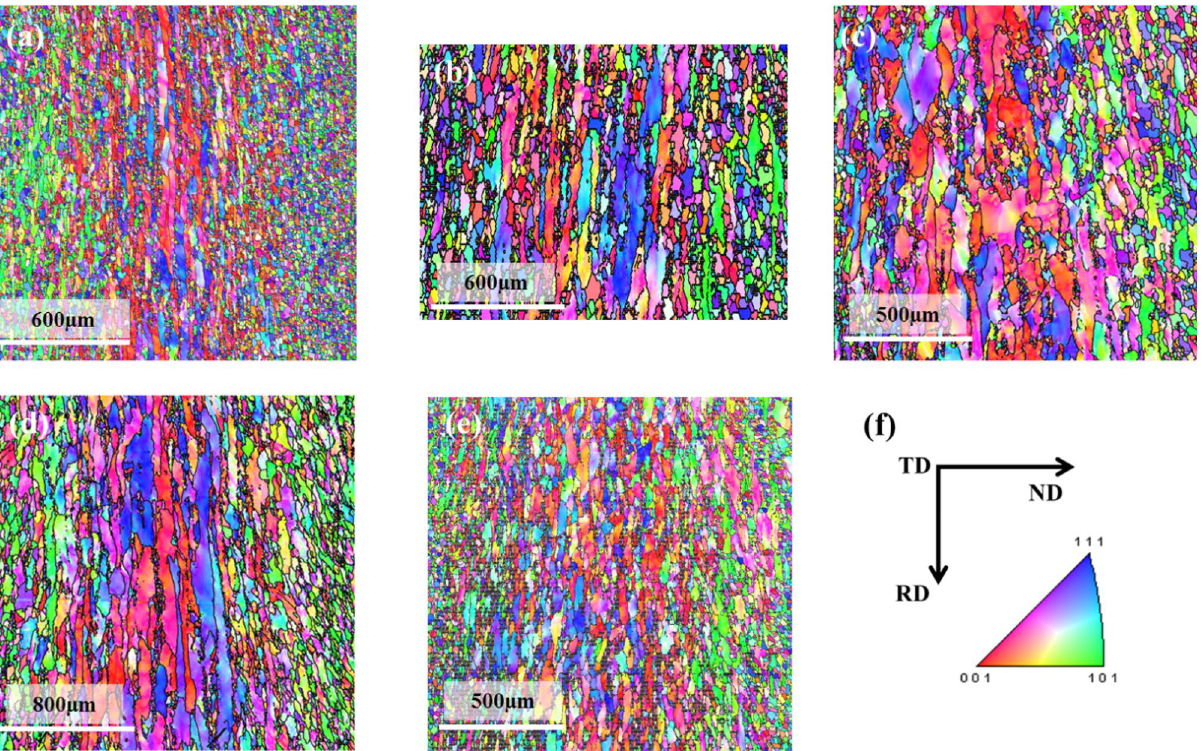
Figure 6. IPF maps of hot bands prepared from ( a ) Cast 1, ( b ) Cast 2, ( c ) Cast 3, ( d ) Cast 4, ( e ) Cast 5 and ( f ) directions of the hot rolled strip with respect to the scanned